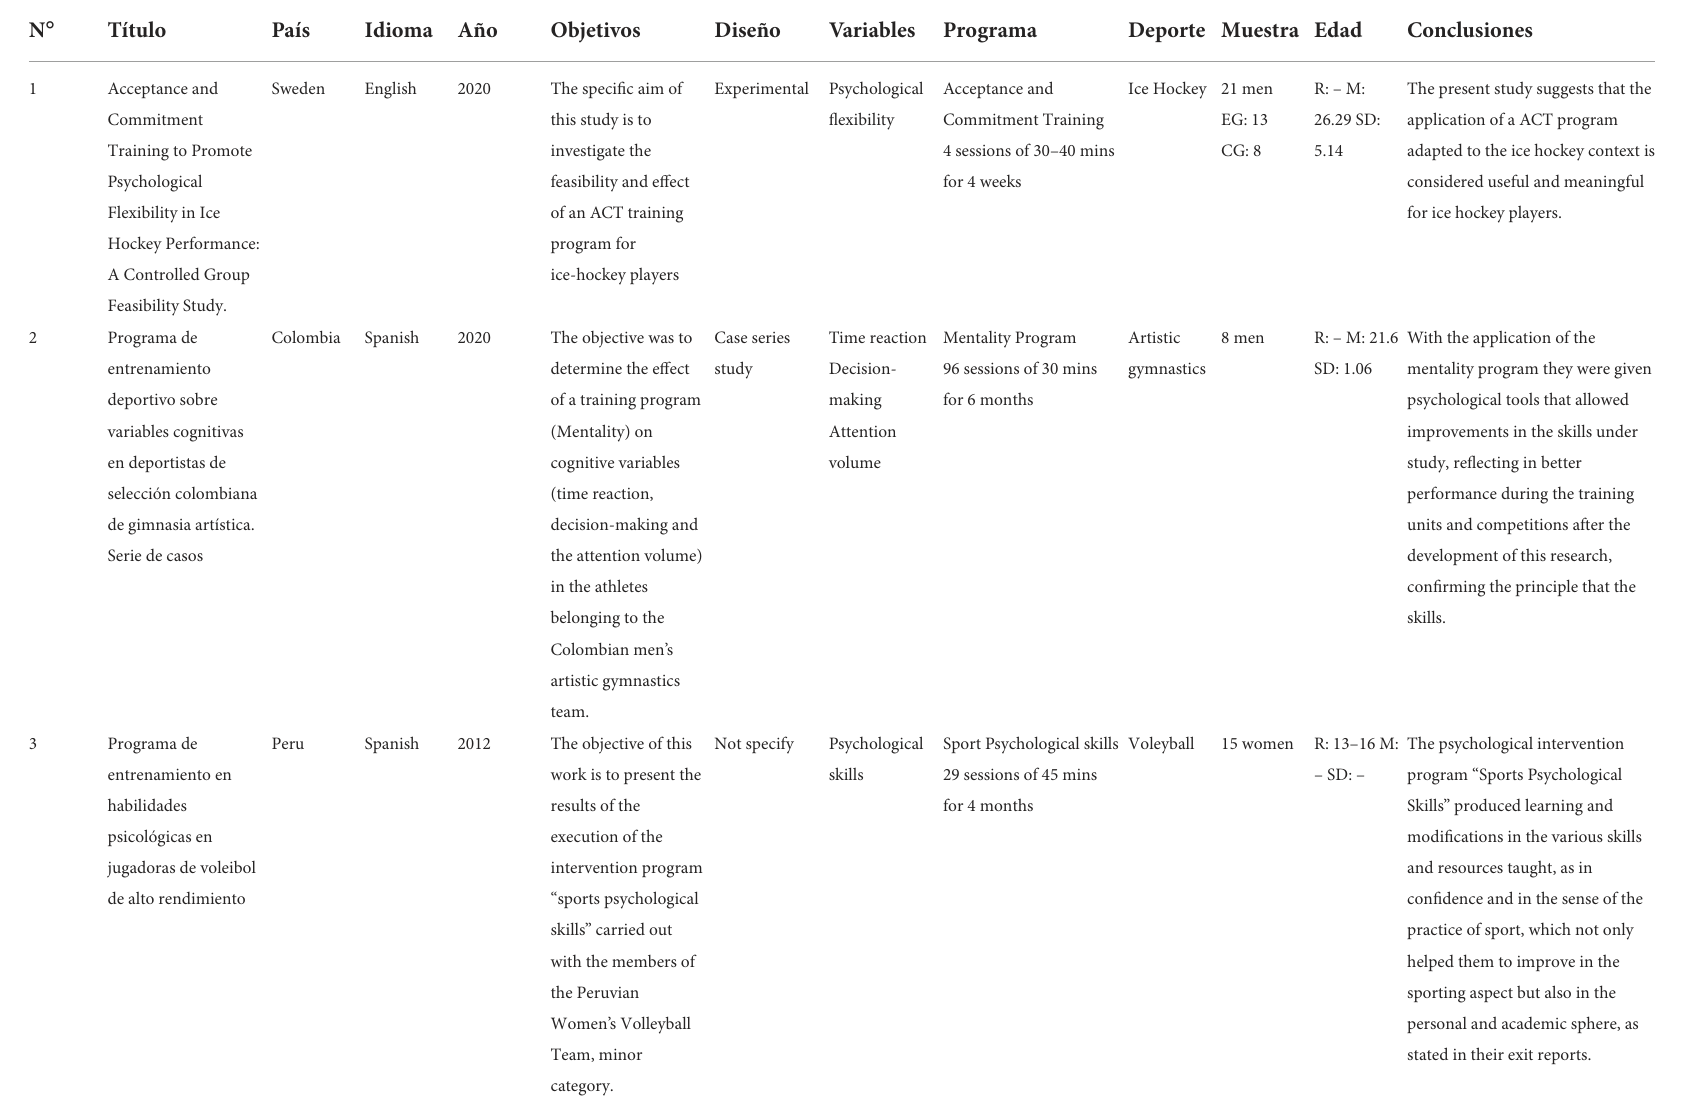
TABLE 2 Descriptive summary of the analyzed